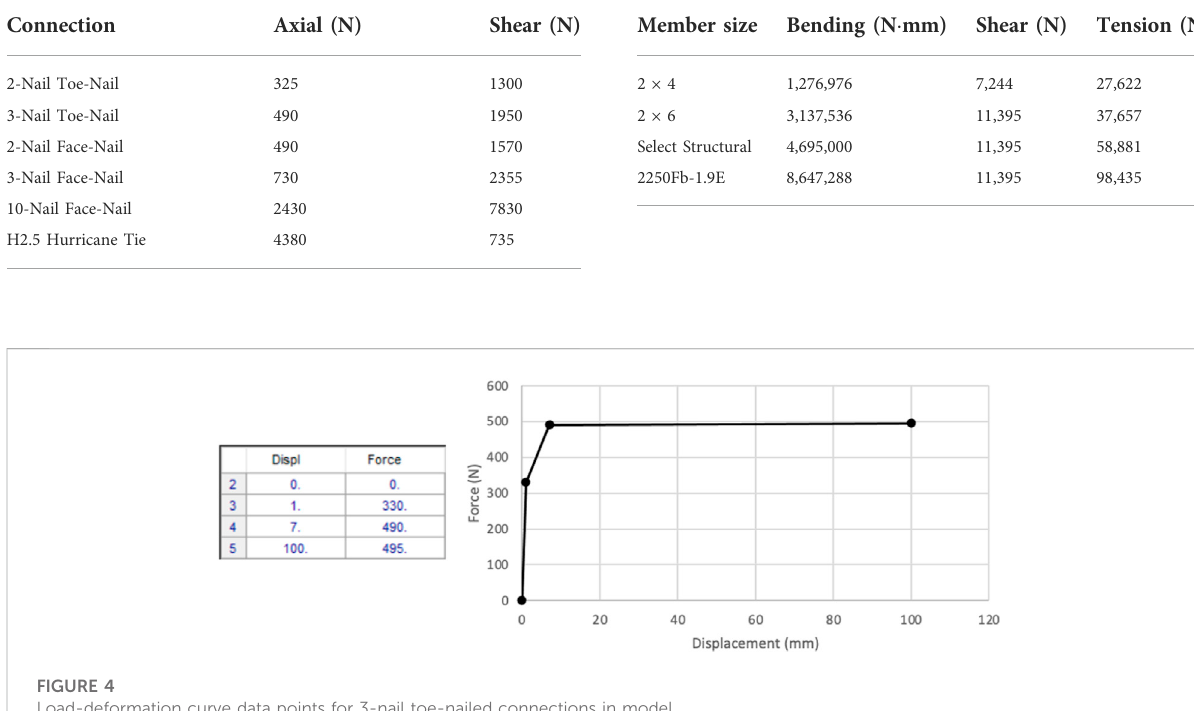
TABLE 1 Design capacities of connections.